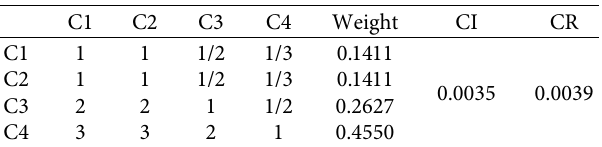
Table 9: Judgment matrix, weight distribution, and consistency test of environmental correlation